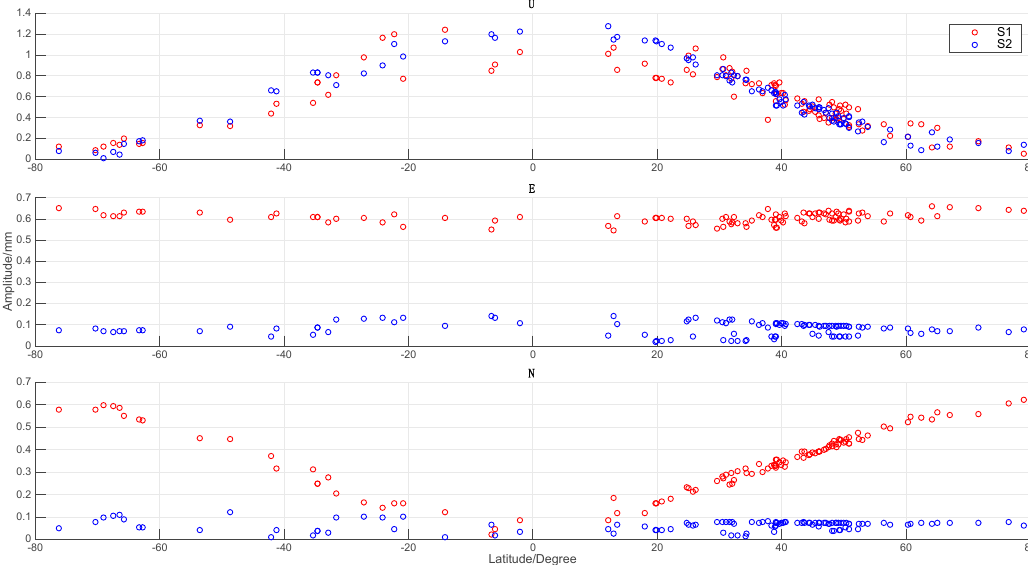
Figure 2. The annual amplitudes of the surface displacements caused by the S1 and S2 tides with respect to the latitude. The red and blue circle represent the S1 and S2 amplitudes, respectively. ( Top ): Up component; ( middle ): East component, ( bottom ): North component.